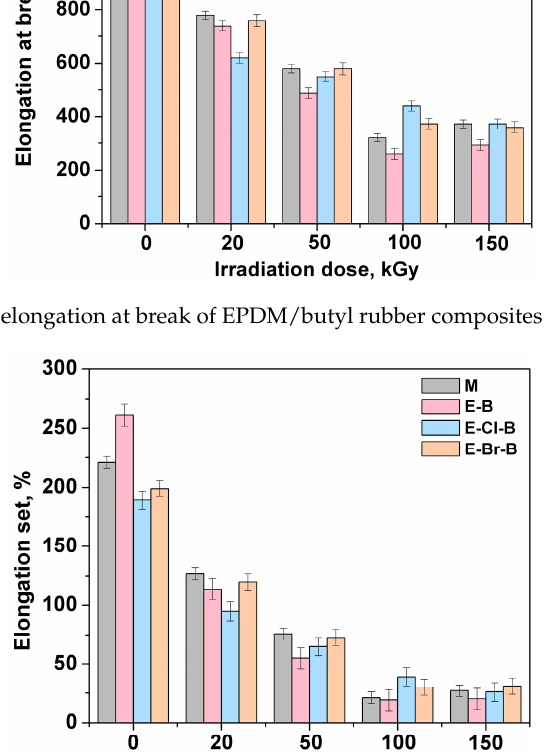
Figure 7. Effect of irradiation dose on elongation set.